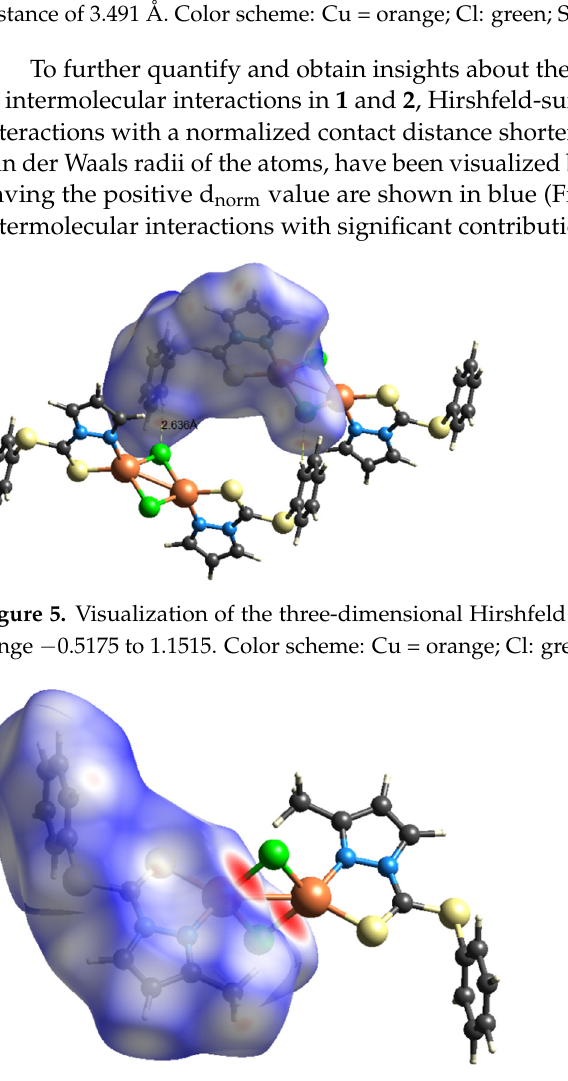
Figure 4. 1D Supramolecular structure of 2 stabilized by C(p) ⋯ S interaction, with a separation distance of 3.491 Å. Color scheme: Cu = orange; Cl: green; S = yellow; and N = blue.